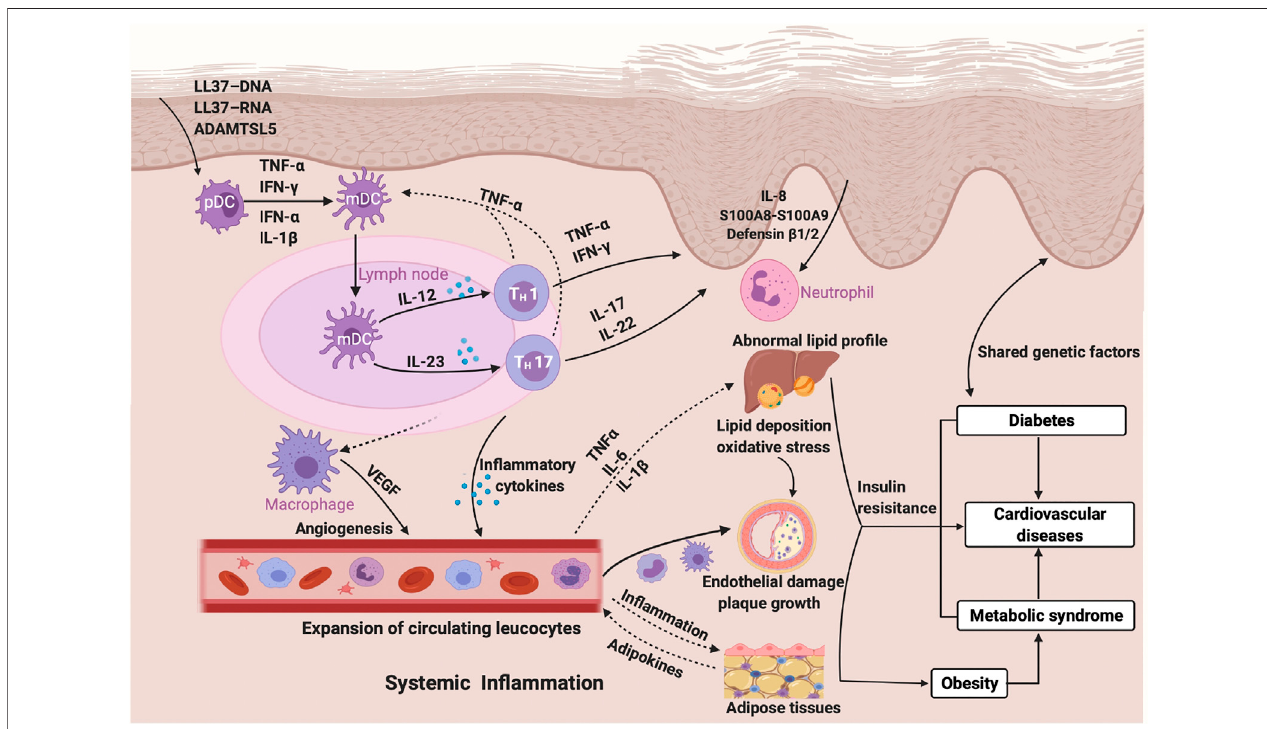
FIGURE 1 | Psoriasis, cardiometabolic comorbidities, and their common in fl ammatory pathway.